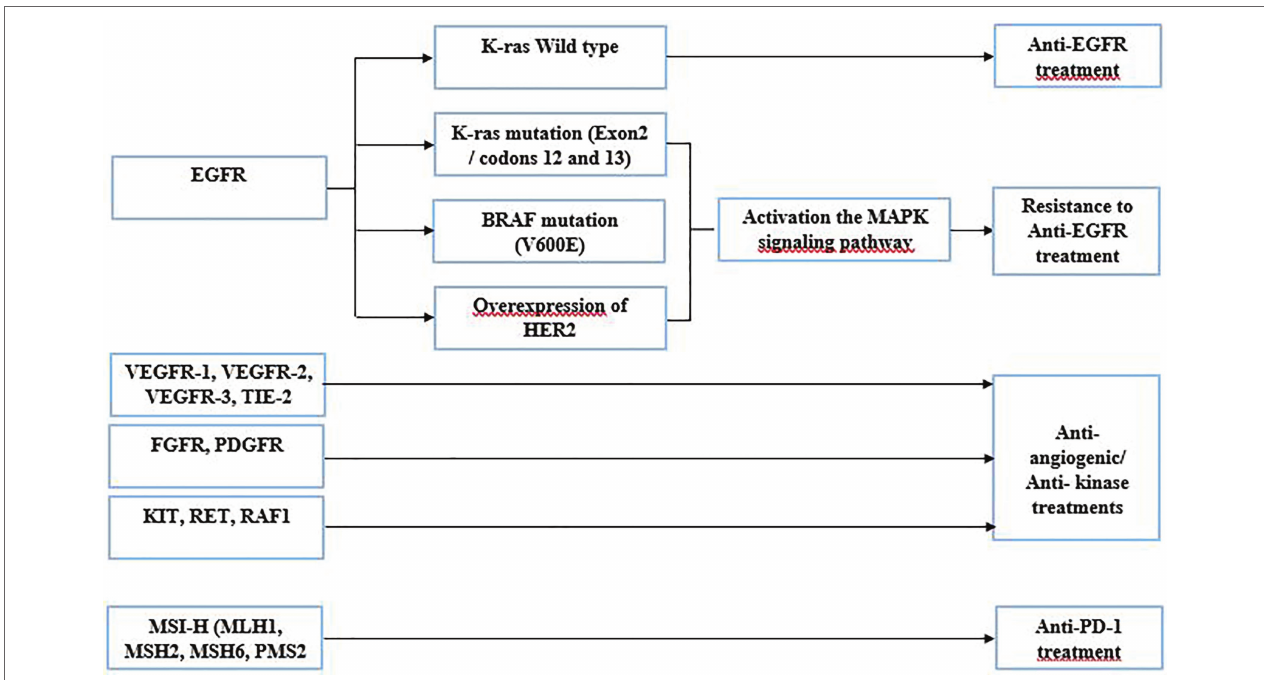
FIGURE 2 | Gene alterations used in CRC